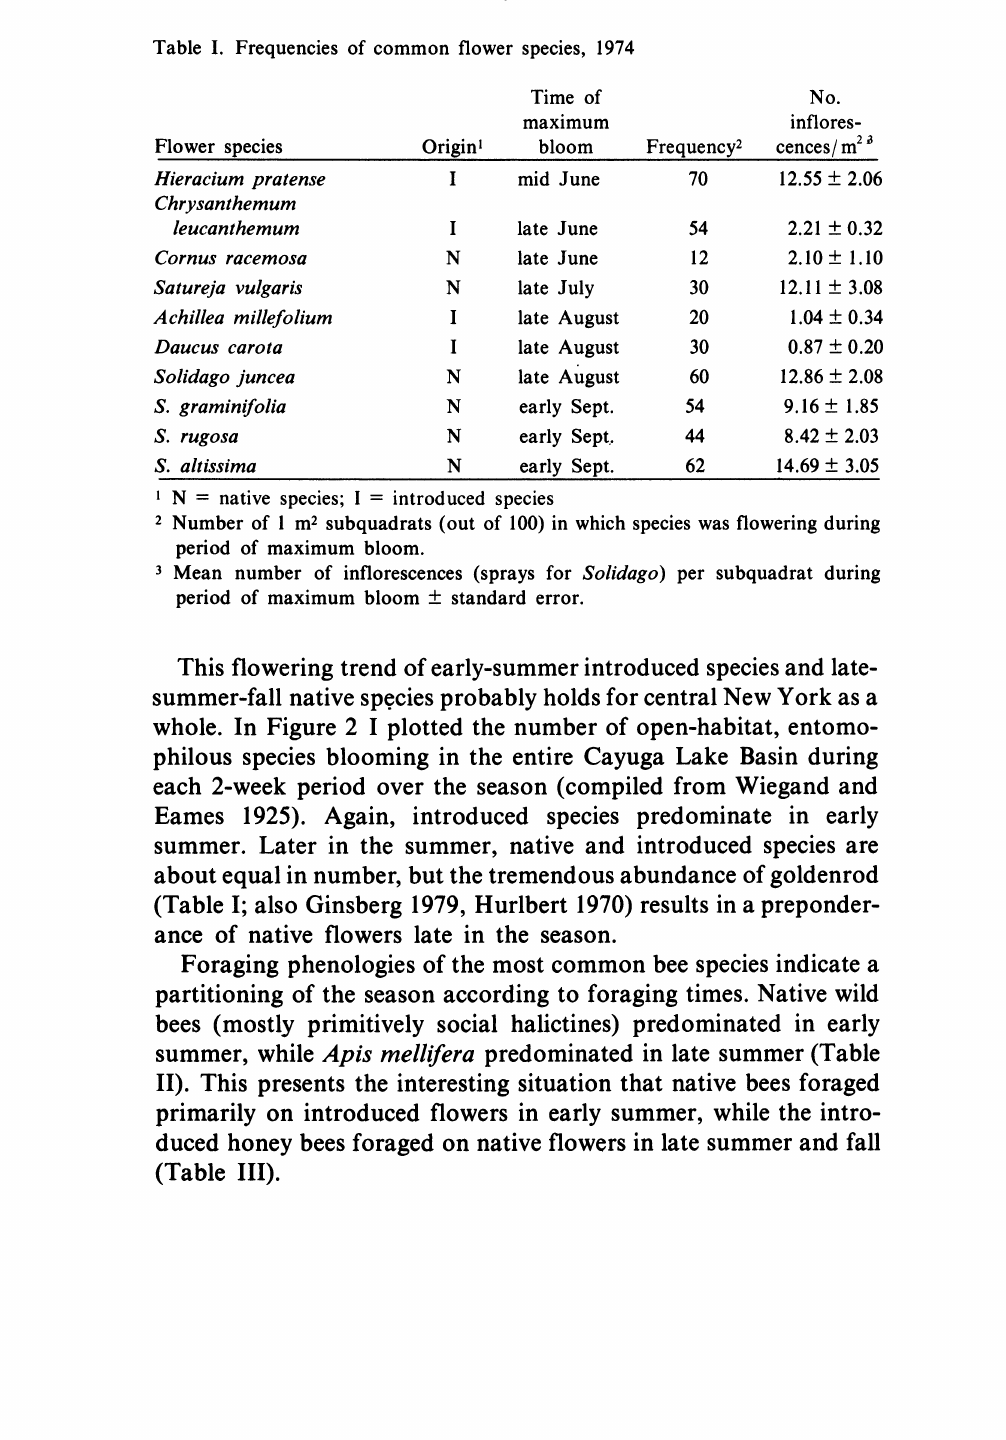
Table I. Frequencies of common flower species, 1974 Time of